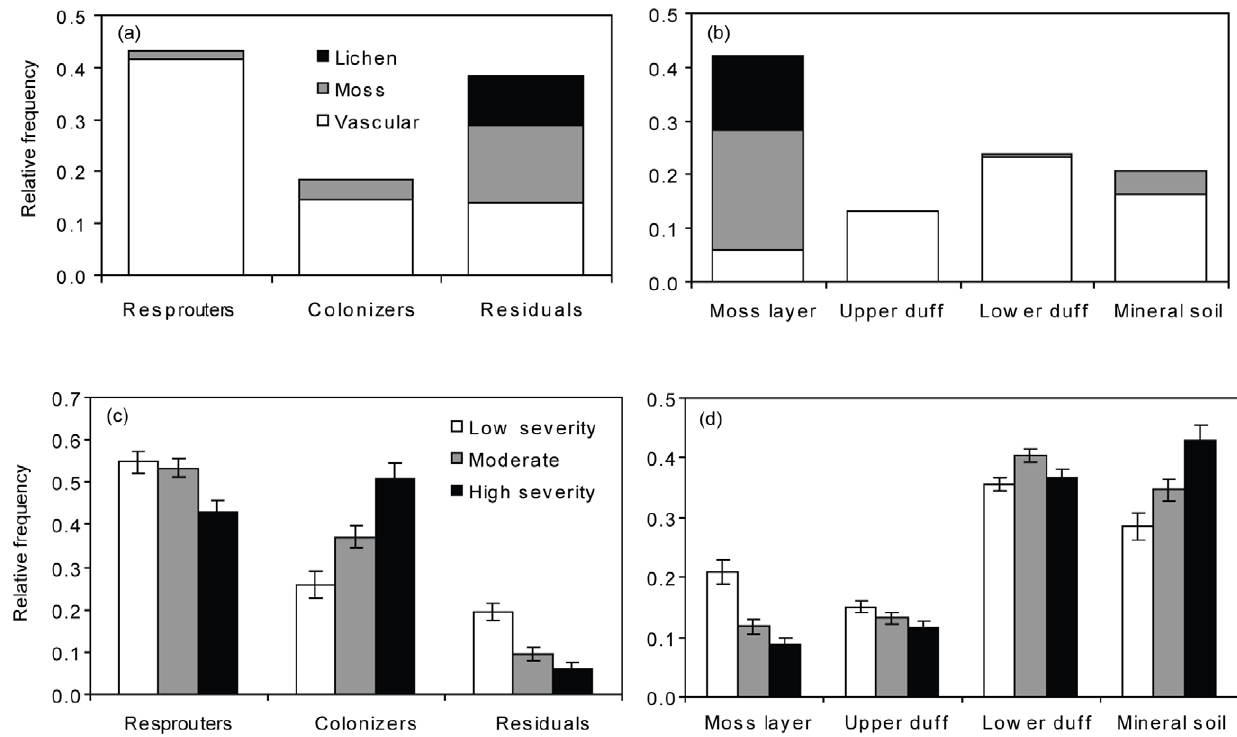
Figure 4. Histograms depicting the distribution of plant traits. Distributions range across the regional species pool of post-fire black spruce communities (a,b) and the realized, abundance-weighted trait distribution in post-fire communities that experience different levels of fire severity (c,d). Two sets of traits related to post-fire regeneration are shown: (a,c) Regeneration mode separated into categories of regenerators, colonizers, and residuals, and (b,d) Distribution of belowground biomass across different rooting substrates (moss, upper duff, lower duff, and mineral soil). For the regional species pool, the distribution of traits has been separated into understory growth forms of lichens, mosses, and vascular plants.